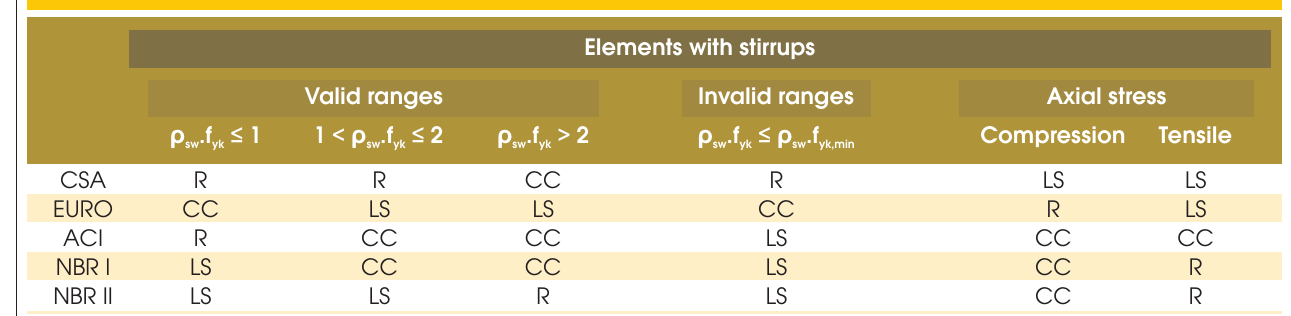
Table 7– Qualification of prediction's models, for safety use, for elements with